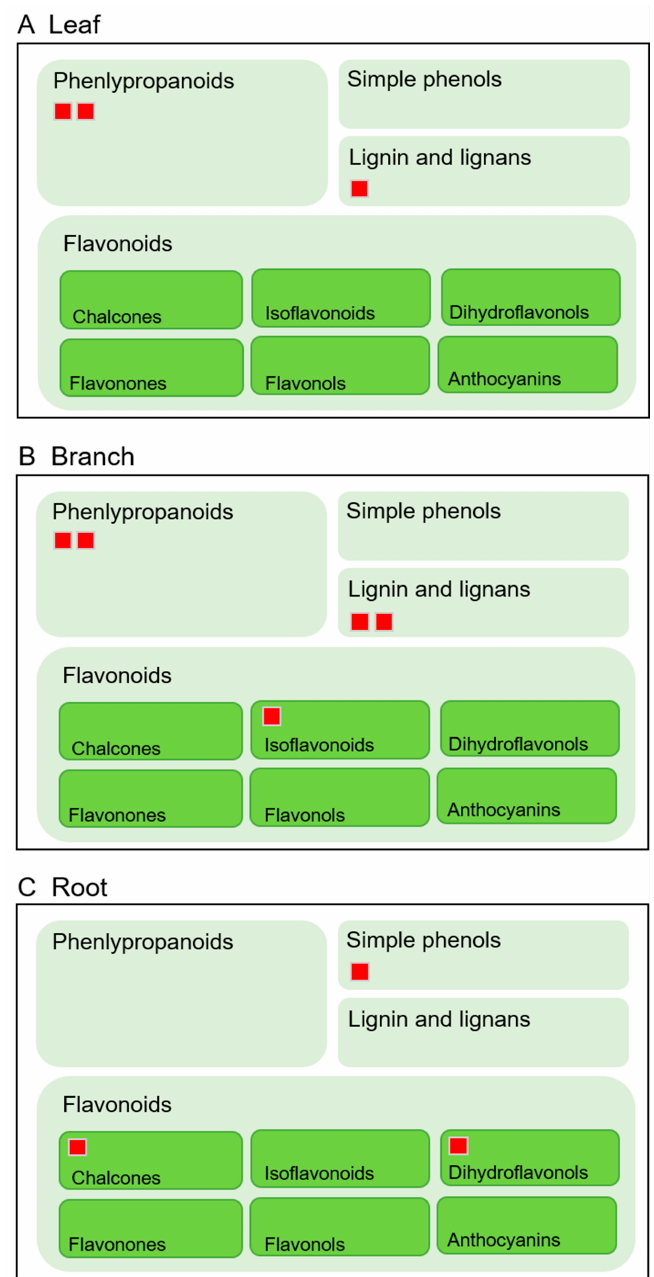
Figure 4. Comparison of the organ-specific proteins related to the flavonoid, phenlypropanoid, simple phenol, and lignin. Leaf- ( A ), branch- ( B ), and root- ( C ) specific proteins related to secondary metabolism were submitted to the MapMan software (version 3.6.0RC1). Each red square indicates one mapped protein.